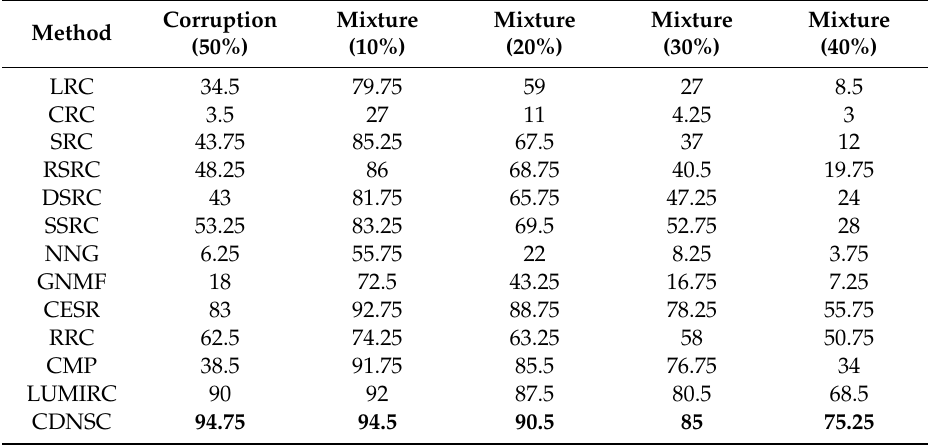
Figure 8. Query samples with dense corruption or mixed-contaminations in the test set of the CASIA database. ( a ) The original sample, ( b ) Sample with 50% corruption, ( c – f ) Samples with 10%–40% mixed-contaminations. Table 1. Recognition rates (%) of all the methods with respect to the two kinds of